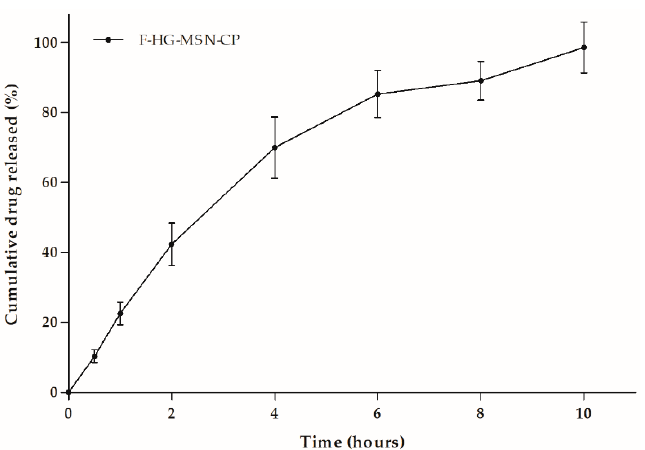
Figure 10. Cumulative drug release (%) of 3D-printed F-HG-MSN-CP, evaluated using the Franz diffusion method.